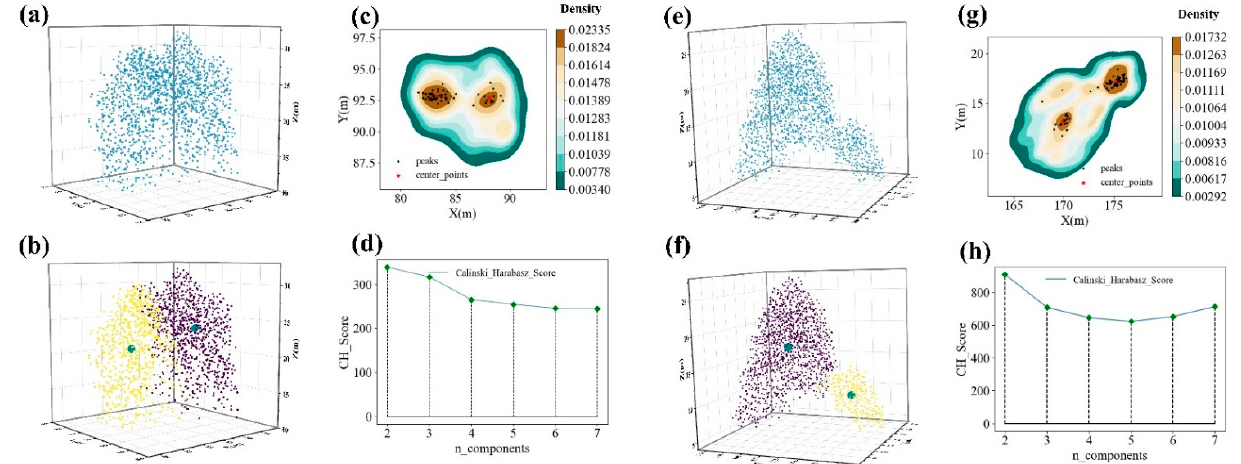
Figure 7. ( a , b , e , f ) Subsample approximate center points are calculated based on the homogeneous group composed of high-density points, and the clustering is performed by initializing the Gaussian mixture model clustering center with this; ( c , d , g , h ) density peak point detection based on the Gaussian kernel density of the sample ground projection point set, and the number of under-segmented sample subsamples is determined by calculating the CH score through iterative clustering. The scale of the color bar represents the Gaussian kernel density of the projection point.